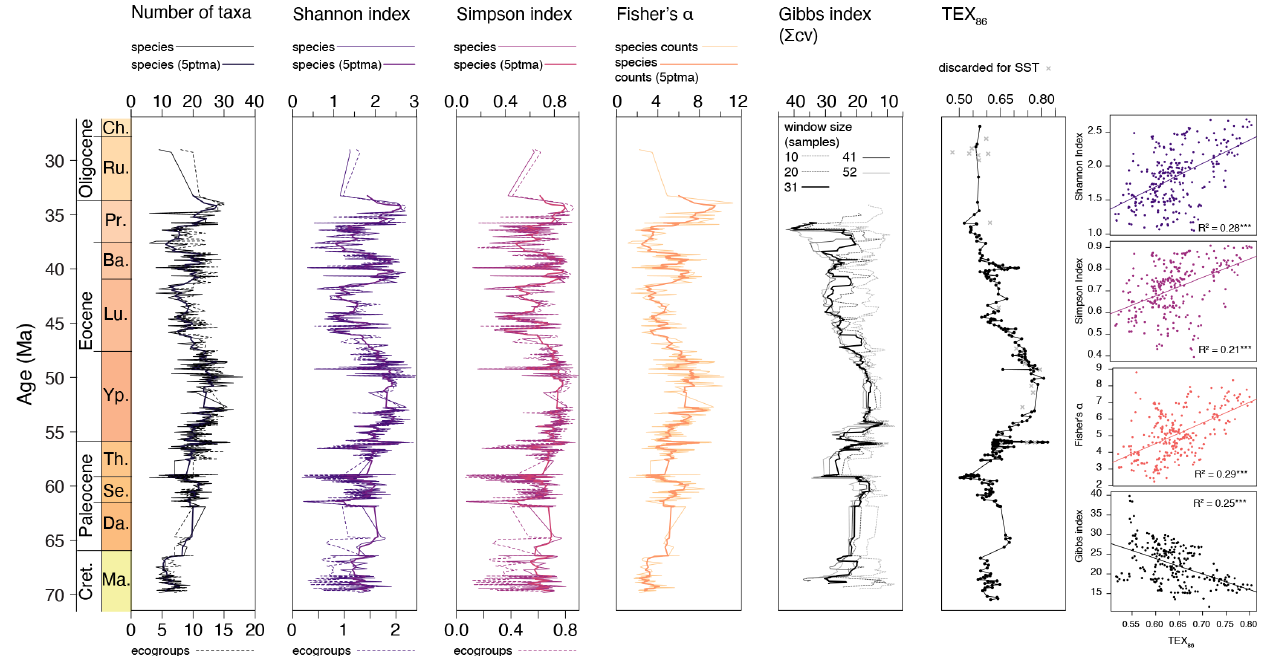
Figure 14. Dinocyst taxonomic diversity and variability through time. From left to right: plotted number of taxa (black), Shannon index (purple), Simpson index (pink), Fisher’s alpha (orange) (species-based dataset in solid lines; eco-grouped dataset in dashed lines) and Gibbs index (note the reversed axis; different window sizes in gray–black). TEX 86 plotted for comparison. Gray crosses indicate samples that have non-pelagic or non-thermal contributions. Cross plots show correlation of these indices with TEX 86